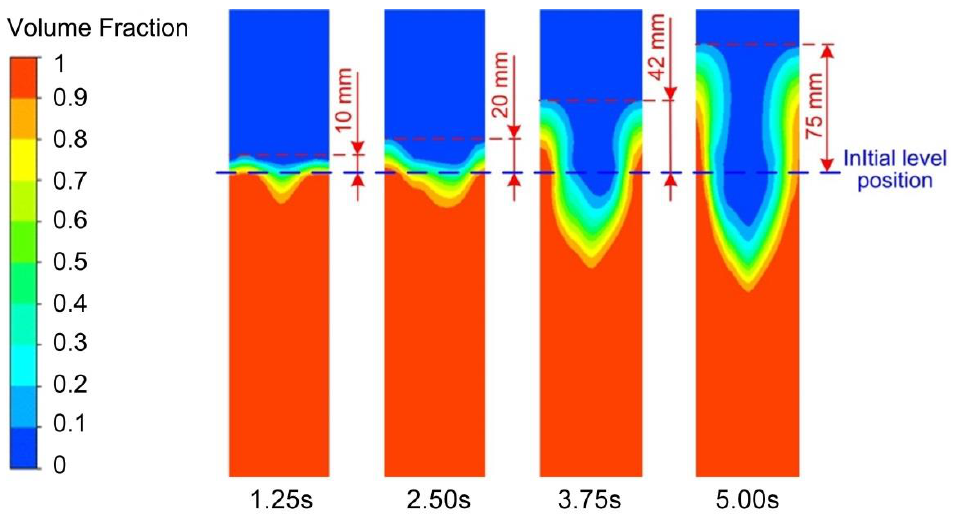
Figure 19. Vortex-shaped structure generation process under the high level of EMS.